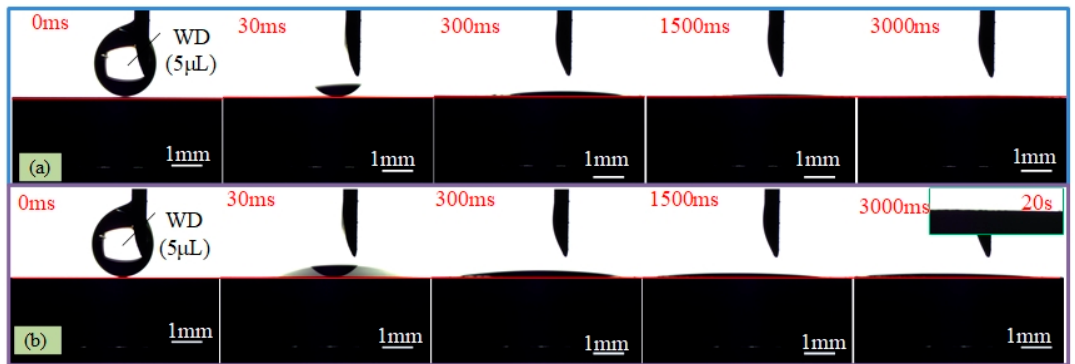
Figure 8. Sequential photographs of WCA measurement on ( a ) the first-step laser-irradiated surface using F p1 = 4.0 J/cm 2 and ( b ) two-step laser-irradiated surface using F p1 = 4.0 J/cm 2 along with F p2 = 2.4 J/cm 2 .